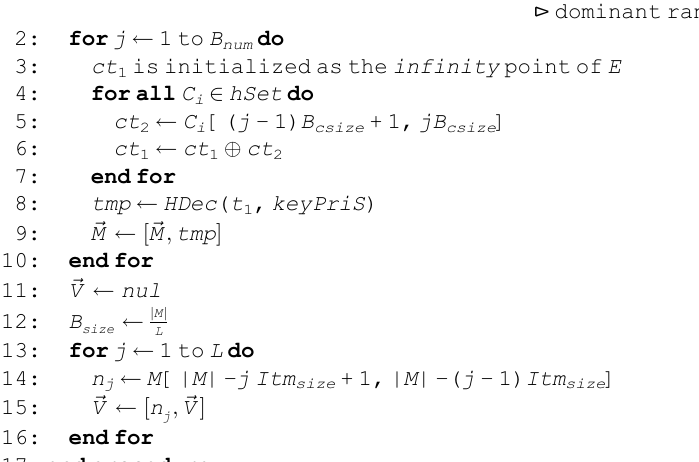
Algorithm 4 Operations on Server (Part